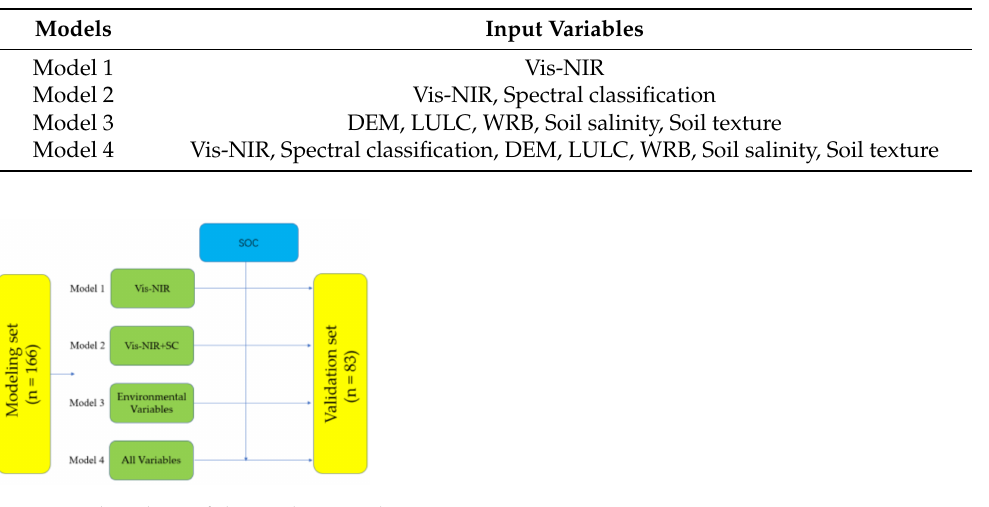
Figure 2. Flowchart of the study